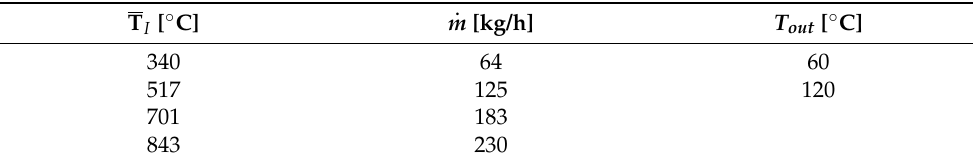
Table 4. Central variation parameters: average inventory temperature (T I ) at the end of charging . period, total mass flow rate ( m ), constant mixing temperature (T out ).